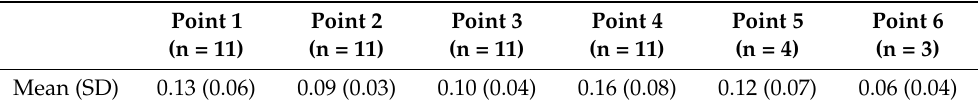
Table 2. Mean values and standard deviations of discrepancies among the six points (as shown in Figure 3) evaluated with the optical 3D method